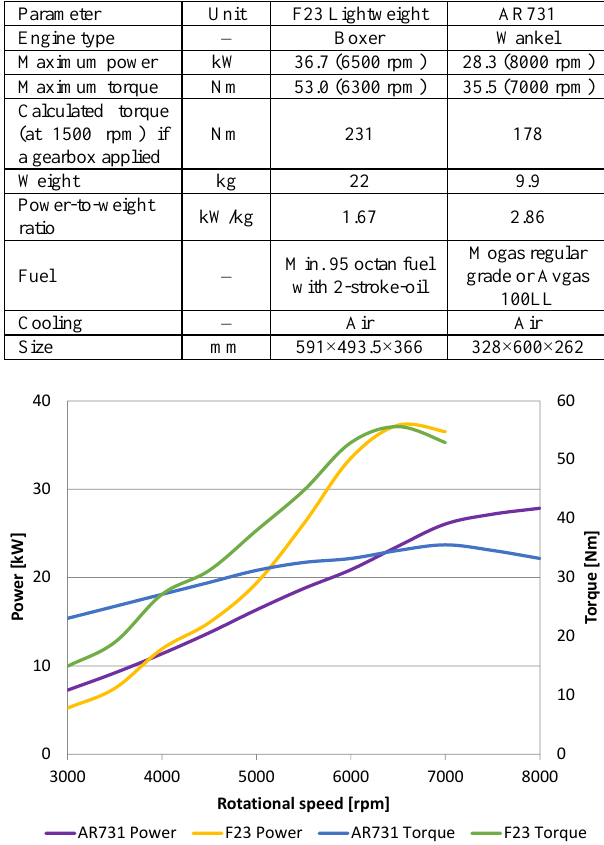
Table 1. Selected parameters of internal combustion engines [14, 24]